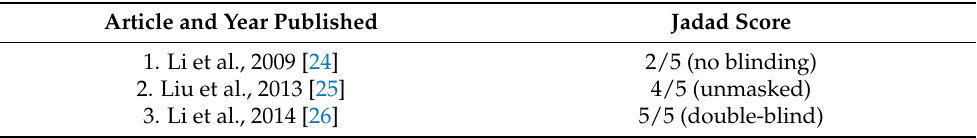
Table 2. The Jadad scores of the three articles used for this systematic Table 1. List of articles reviewed in this study and the study characteristics.